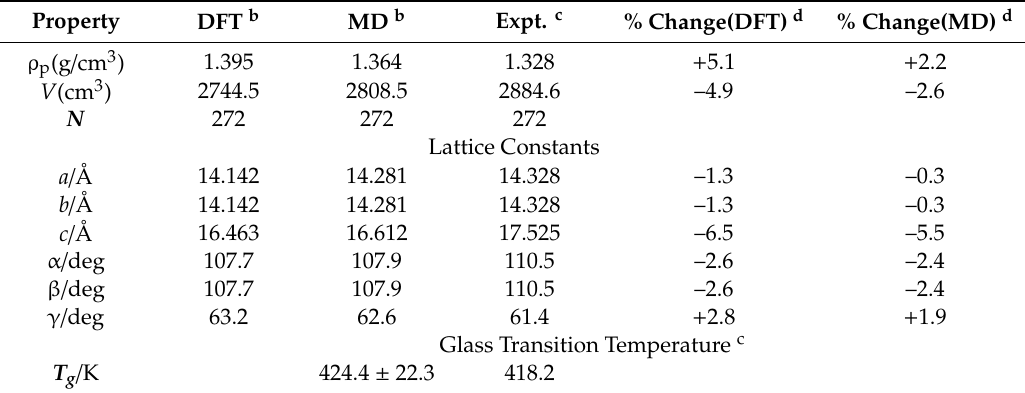
Figure 1. ( a ) The ball-and-stick model of the unit-cell geometry of o-PEEK, obtained using PBEsol. ( b ) The 2 × 2 × 2 supercell model of o-PEEK. Both ( a ) and ( b ) were used for MD simulation of glass transition temperature. Labeling of atom type is shown in ( a ). Table 1. Comparision of selected DFT-PBESol and MD (COMPASS II) calculated unit-cell properties of o-PEEK with experiment. a.